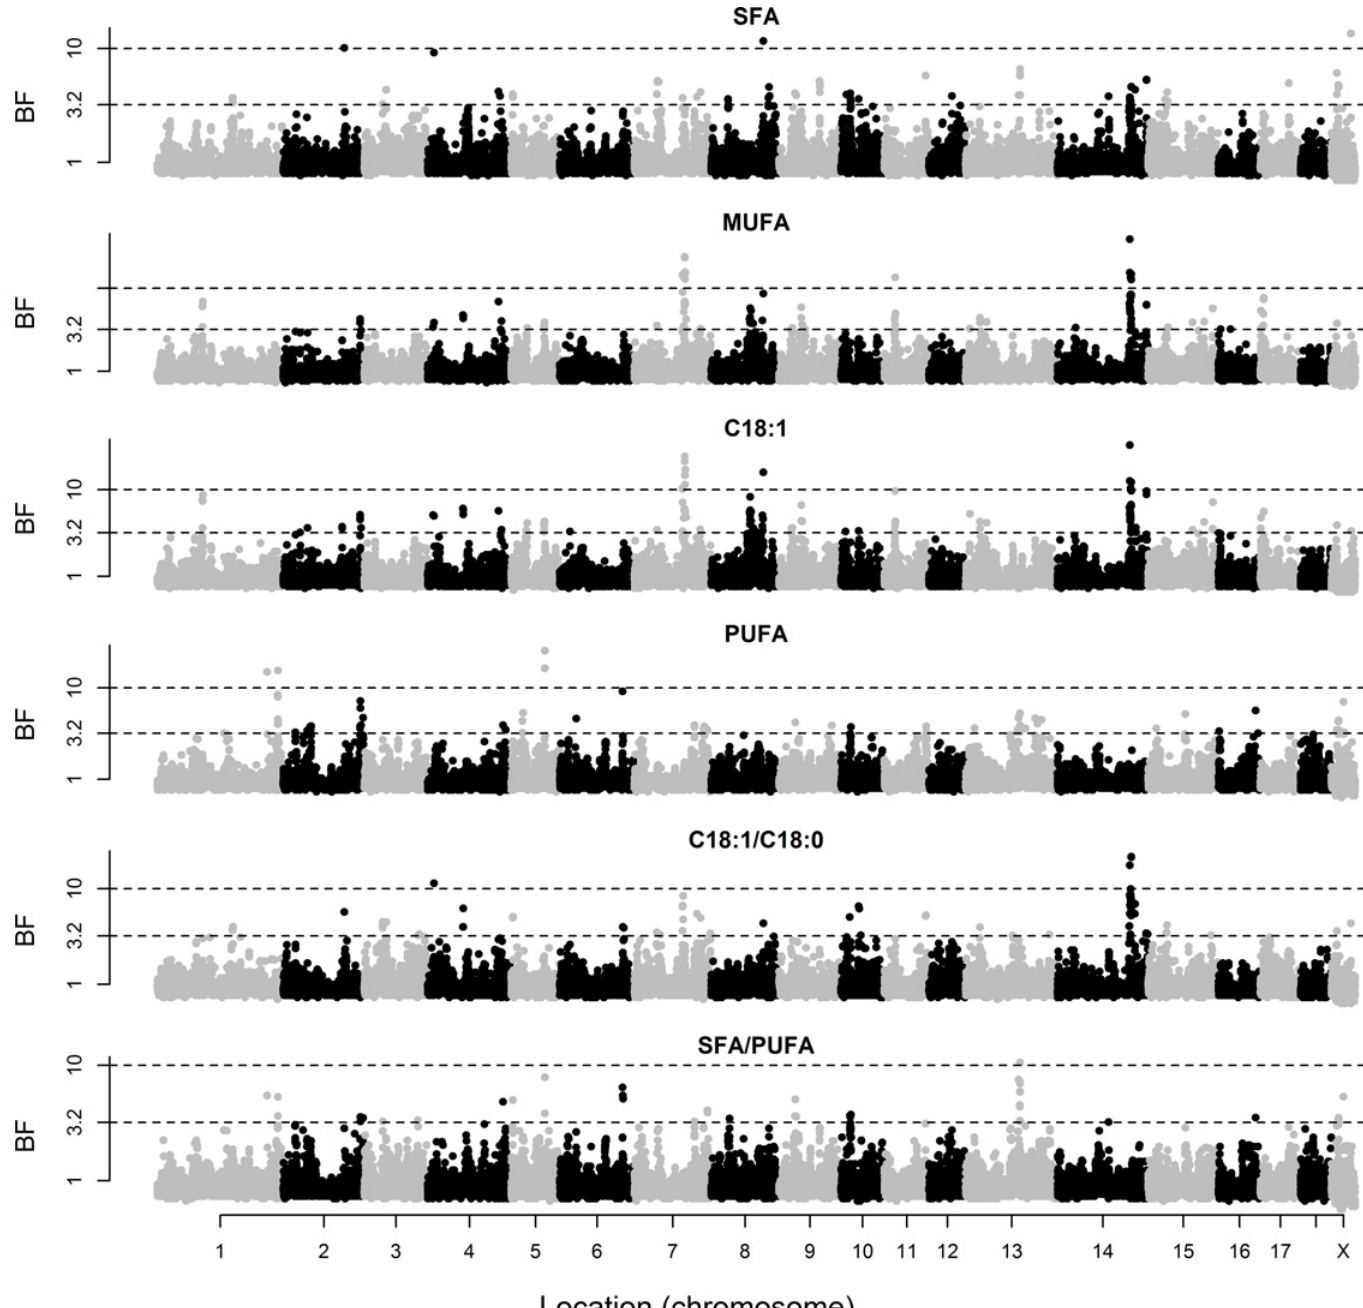
Fig 3. Bayes factors of individual markers for subcutaneous fat composition. Fatty acid composition includes saturated (SFA), monounsaturated (MUFA), and polyunsaturated (PUFA) fatty acids, individual oleic acid (C18:1), and the ratios of oleic to stearic acid (C18:1/C18:0) and SFA/PUFA. The discontinuous lines indicate Bayes Factors of 3.2 (substantial evidence), 10 (strong), and 100 (decisive).